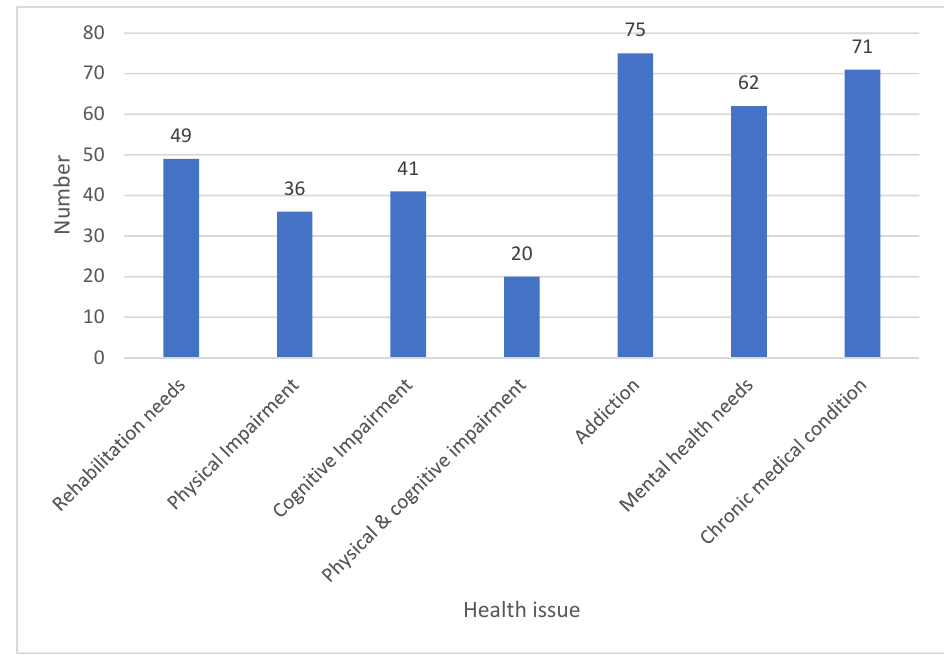
Figure 3. Needs identified in cases discussed.